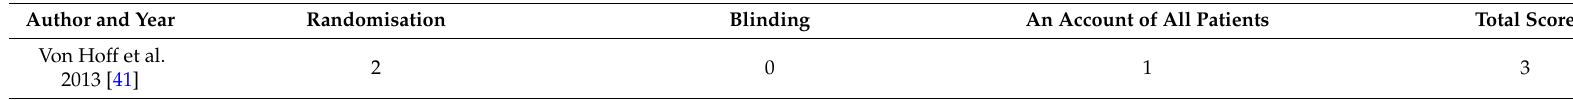
Table 3. Quality assessment of included studies. Table 3a. Quality assessment of included randomised controlled trial using the JADAD score.